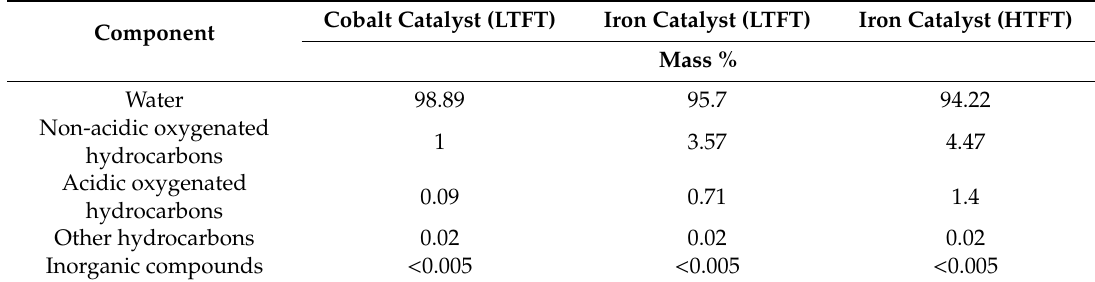
Table 6. Composition of F–T reaction water from di ff erent F–T synthesis operating modes [118].